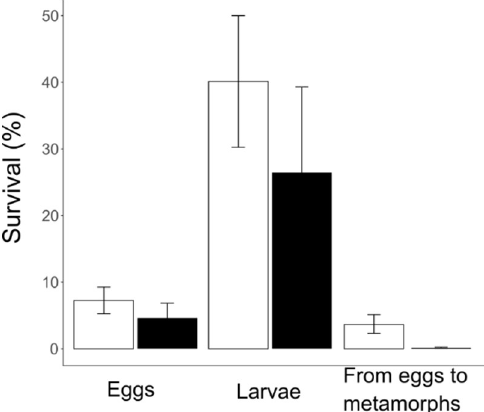
Figure 3: Mean survival rates during embryonic stage (hatching rate n = 86), larval stage (n = 27) and from eggs to juveniles (n = 90) of spring cohorts, in presence (black) or absence (white) of older tadpoles laid in autumn. Error bars are standard errors, among sites, among